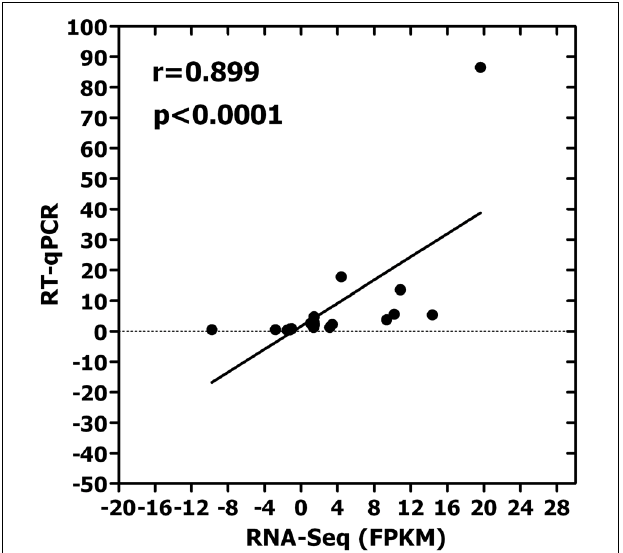
FIGURE 5 | Correlation analysis for 21 candidate genes between RNA-Seq and RT-qPCR ( r = 0.899, p < 0.001). [Both of software SPSS v17.0 (IBM Inc., Chicago) and the GraphPad prism 5 were all used for data analyses and the figure was made by Graphpad prism 5. The X -axis represents the value of FPKM in RNA-Seq, which was used in calculated expression level. The Y -axis shows the relative expression level of 21 candidate genes in RT-qPCR. The result of correlation analysis shows that there is a high correlation between RNA-Seq and RT-qPCR results. It is suggests that the results of RNA-Seq and RT-qRCR were consistent, and also suggests that the selected DEGs maybe involved in insect resistance. These 21 candidate genes are LTPL 164, LTPL151, LTPL18, LOC_Os07g03880, LOC_Os06g10790, LOC_Os07g18230, CHIT12, CHIT6, LOC_Os07g04220, LOC_Os01g12160, LOC_Os03g15880, LOC_Os05g37690, LOC_Os09g26780, LOC_Os02g34320, LOC_Os04g51070, LOC_Os03g56950, LOC_Os11g32100, WRKY97, WRKY107, WRKY118, and WRKY6,